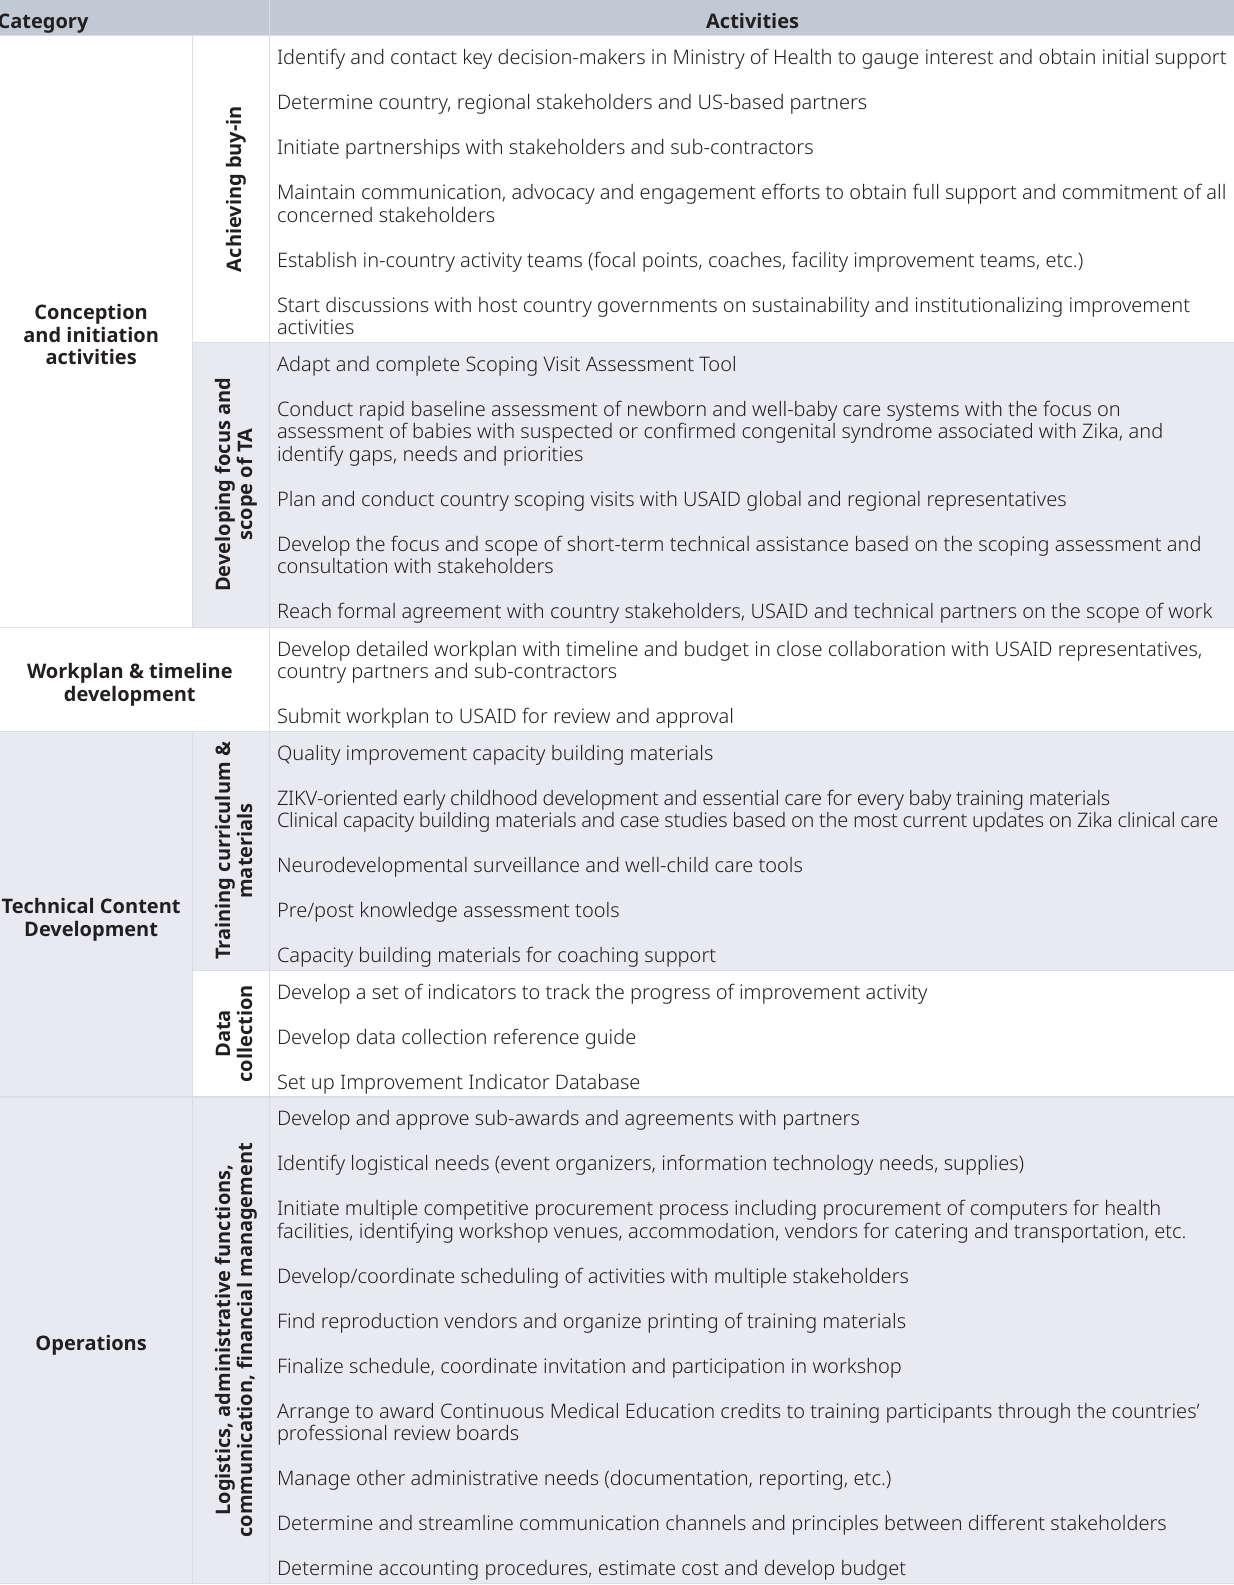
Table 2. Summary list of startup activities.